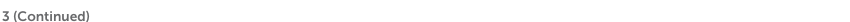
FIGURE3(Continued) confidence level (using the two-tailed Student’s t -test) and are shaded. (C,E,G) Same as (A) , but for (C) OLR, (E) GH (shaded) and the wave activity flux (Takaya and Nakamura, 2001) (vector) at 200 hPa, and (G) velocity potential (shaded) and divergent/convergent flows (vector) at 200 hPa. For (C) , negative correlation (blue color) means that ensemble members that predicted an intense warmer-than-normal condition over Japan mostly tend to predict enhanced convection. (B,D,F,H) Same as (A,C,E,G) , but for 8 cold years (1987, 1992, 1993, 1996, 1997, 2009, 2014, and 2015) (sample size: 108 member × 8 year =